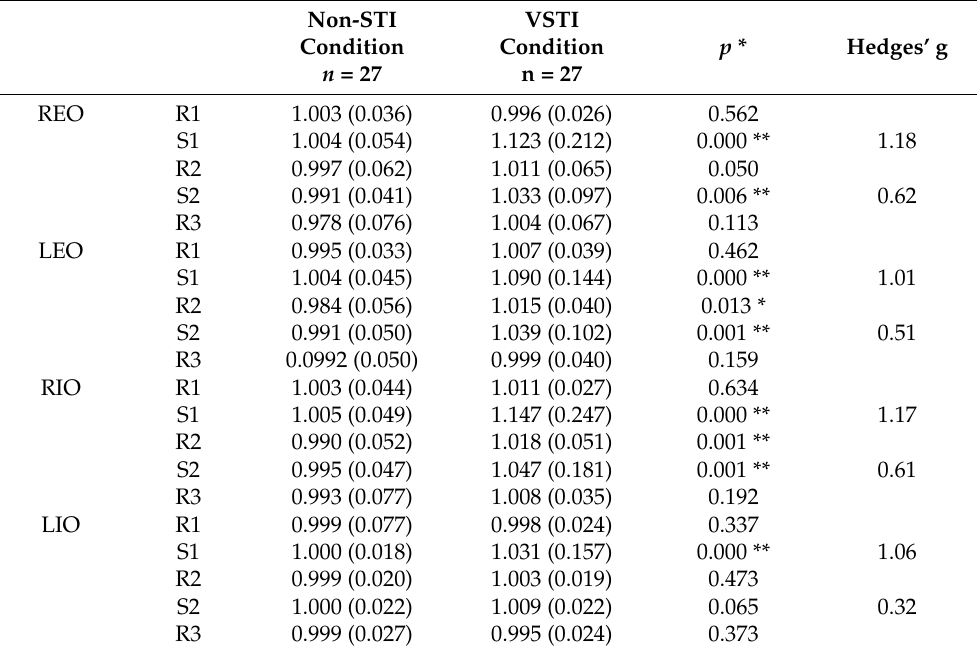
Table 2. Electric muscle activity recorded in both experimental conditions.